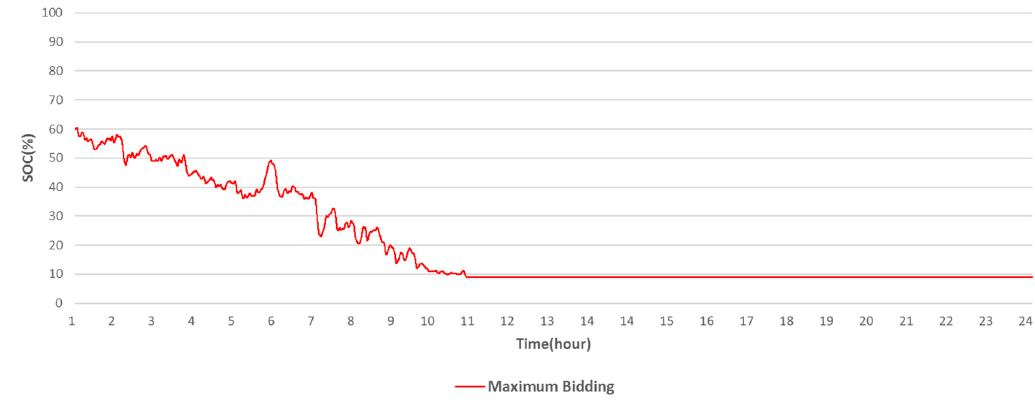
Figure 5. SOC of ESS in real-time operation simulation (Case 1—maximum bidding capacity plan).